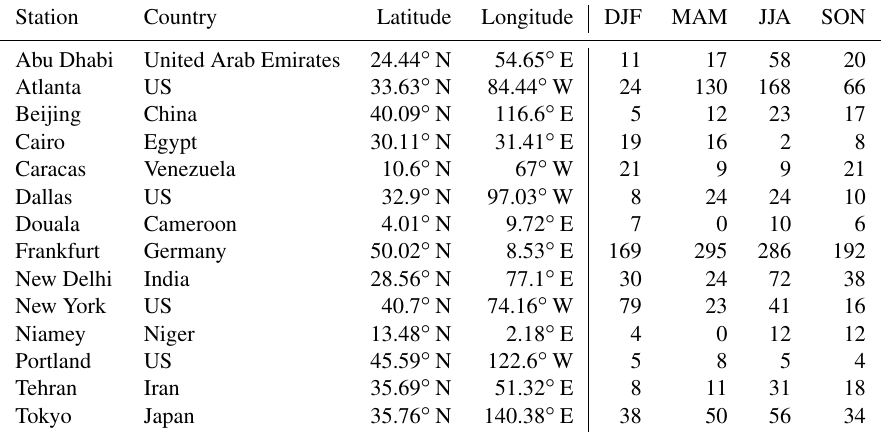
Table 4. MOZAIC aircraft information, including the location of measurements and the number of available measurements for each season (DJF, MAM, JJA and